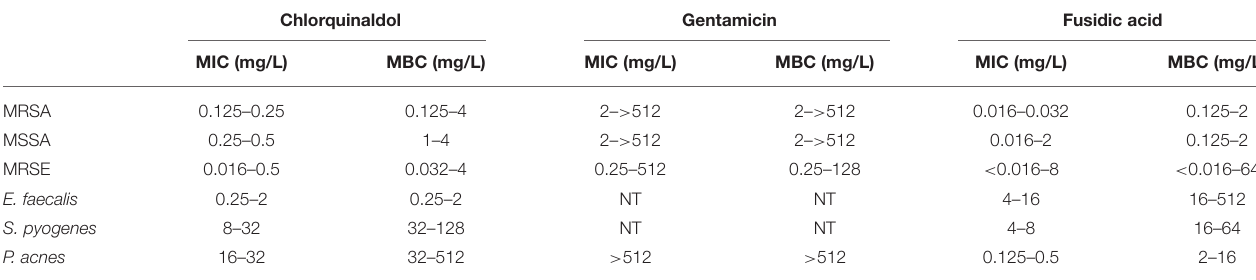
TABLE 1 | MIC and MBC ranges for Gram-positive bacterial strains.